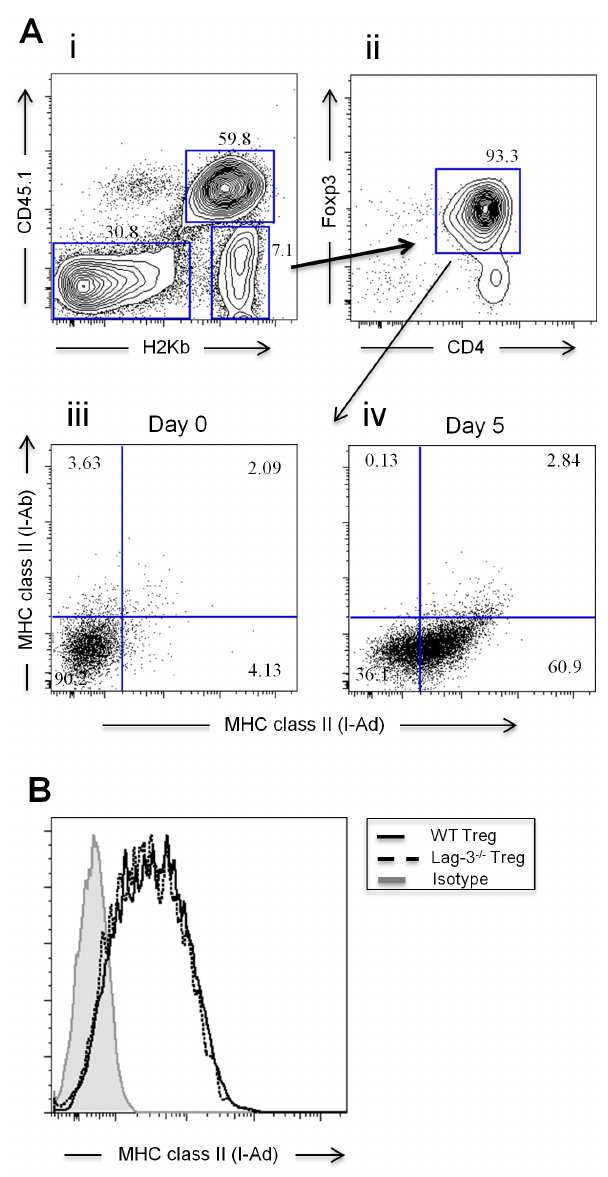
Figure 7. Regulatory T cells acquire MHC class II complexes from host APC. (A) Lethally irradiated Balb/c (H-2K d ) recipients were co-transplanted with 5 6 10 6 TCD-BM, 1 6 10 6 Tcon from CD45.1 + C57BL/ 6 (H-2K b ) mice and 1 6 10 6 WT or Lag-3 2 / 2 Treg. MHC class II expression on donor Treg was assessed 5 days after transplantation. Cells were gated on CD45.1 negative, H2Kb positive (panel i), then CD4 and Foxp3 positive events (panel ii). Panels iii and iv represent the MHC class II expression level on day 0 and day 5 respectively. (B) MHC class II staining on Treg of donor origin (WT or Lag-3 2 / 2 ). Grey histogram represents cells stained with isotype control. Cells were gated on donor CD4 positive, Foxp3 positive events. The histograms are representative of 2 independent experiments each having 4